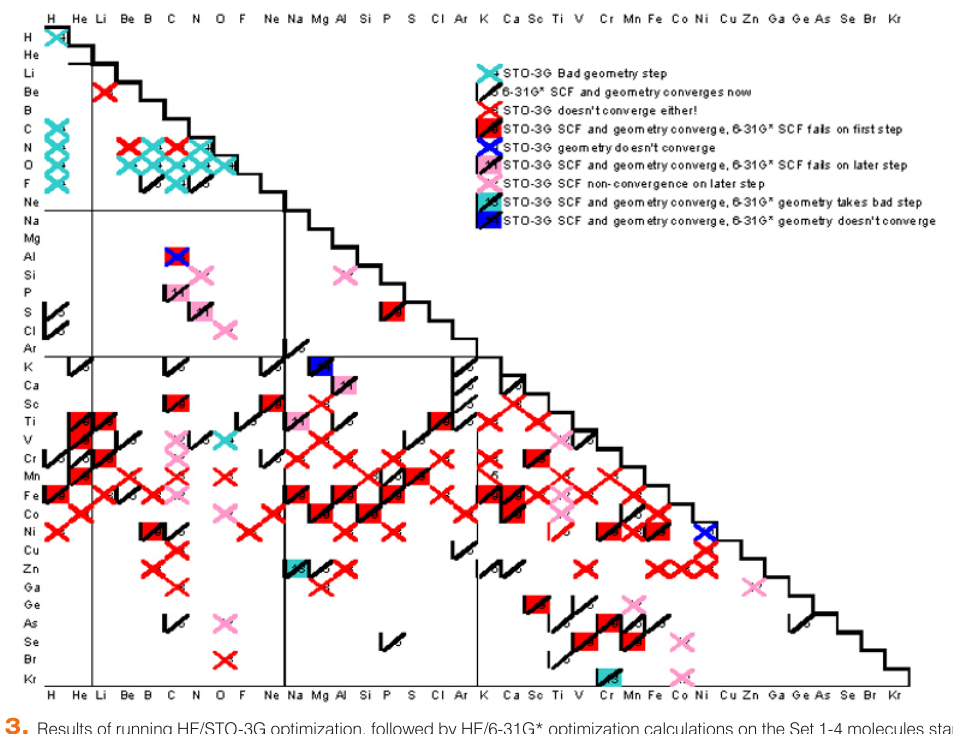
Figure 3. Results of running HF/STO-3G optimization, followed by HF/6-31G* optimization calculations on the Set 1-4 molecules starting with the STO-3G geometry (but not the wavefunction). A black checkmark indicates the HF/STO-3G geometry calculation was successful. A red